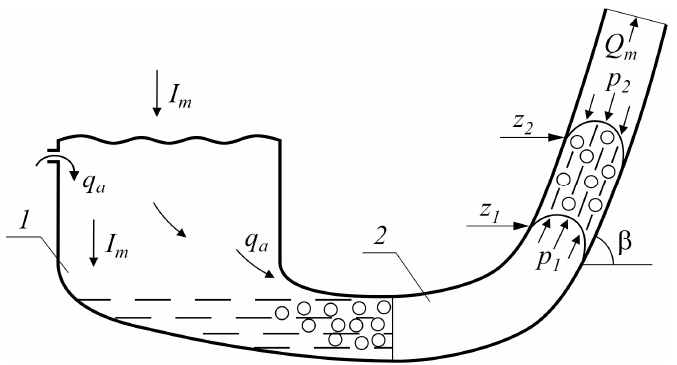
Figure 2. Diagram of milk transportation from the milking machine manifold to the milk pipe (not shown): (1) collector, (2) milk hose.